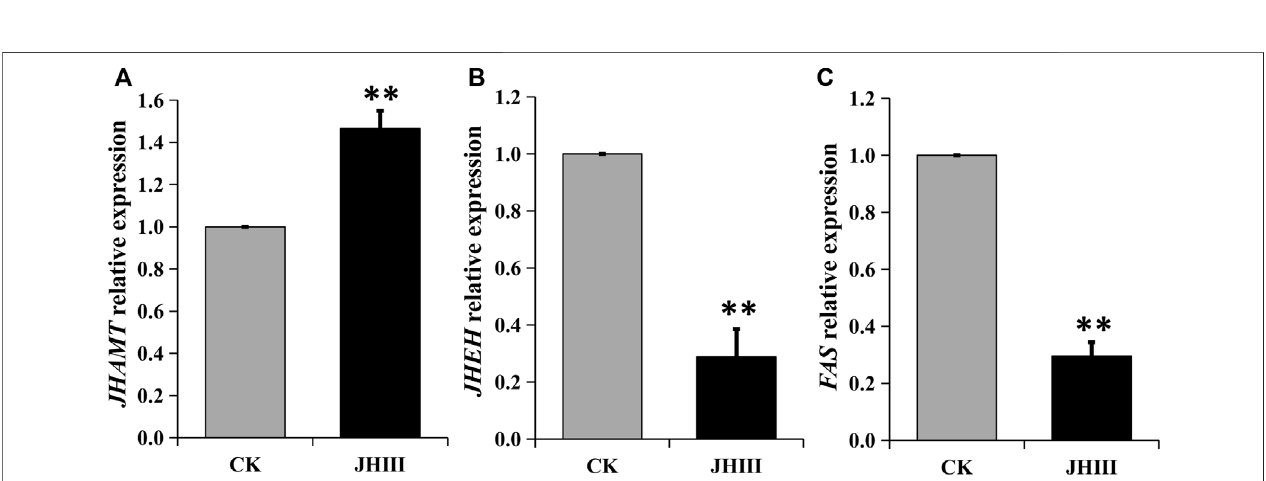
Frontiers in Physiology |